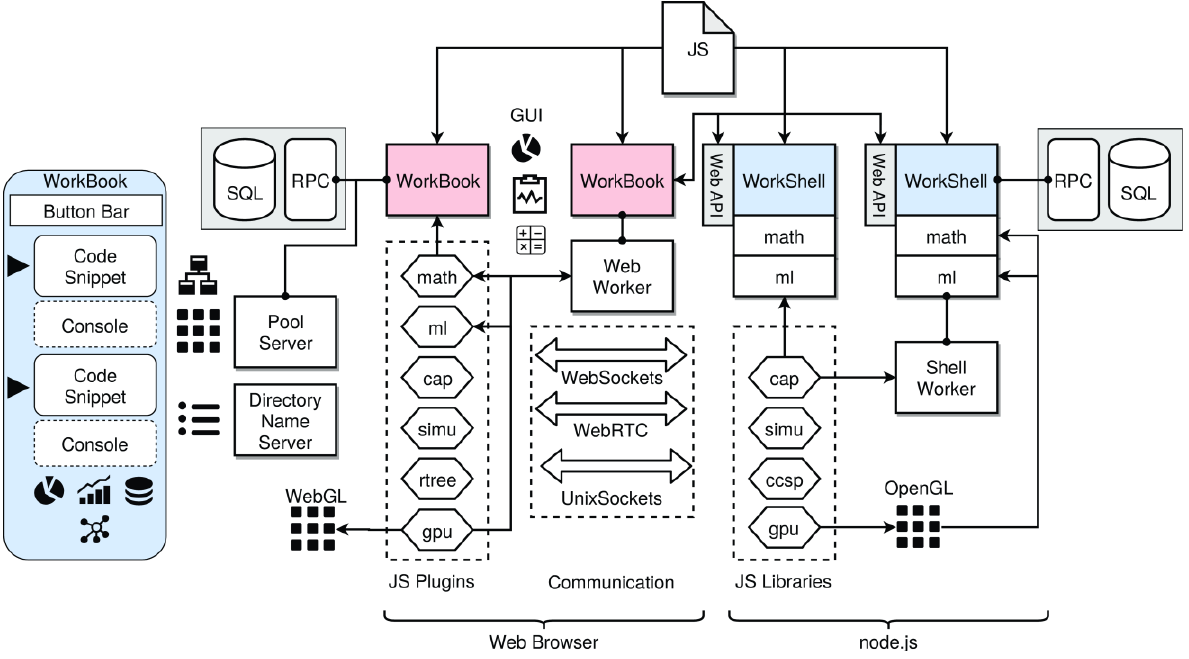
Figure 1. PSciLab software framework and its components (right) and WorkBook GUI layout (left) using code snippets flows with micro consoles.